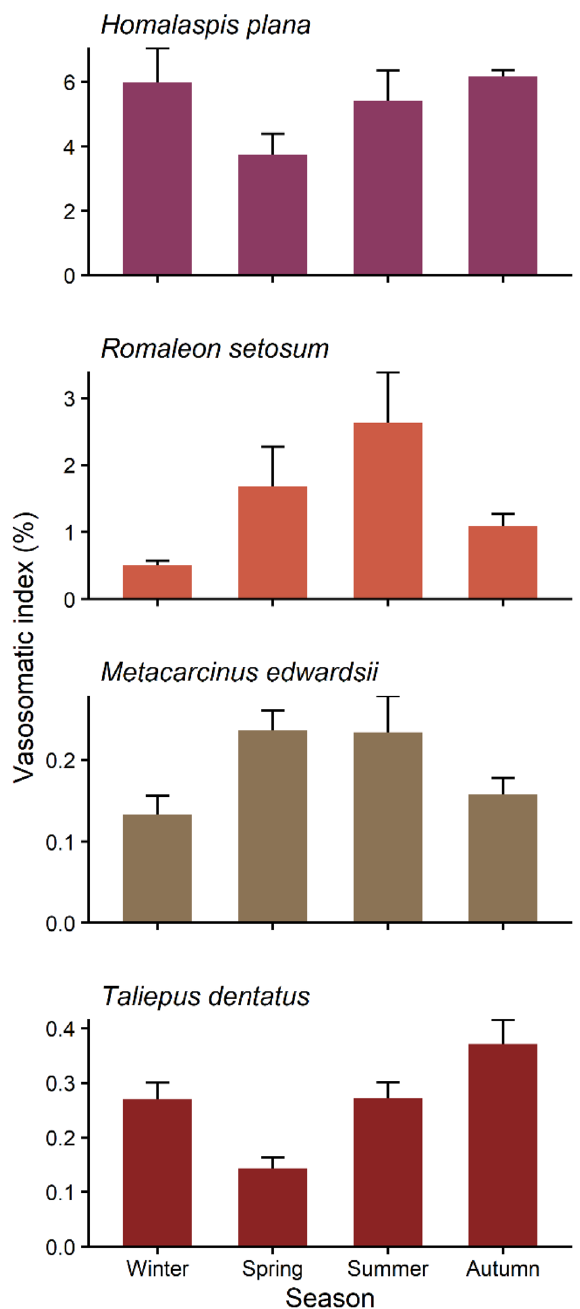
Figure 4. Seasonal pattern of vasosomatic index of the four brachyuran species studied. Values correspond to means + SE . Seasons correspond to austral seasons.